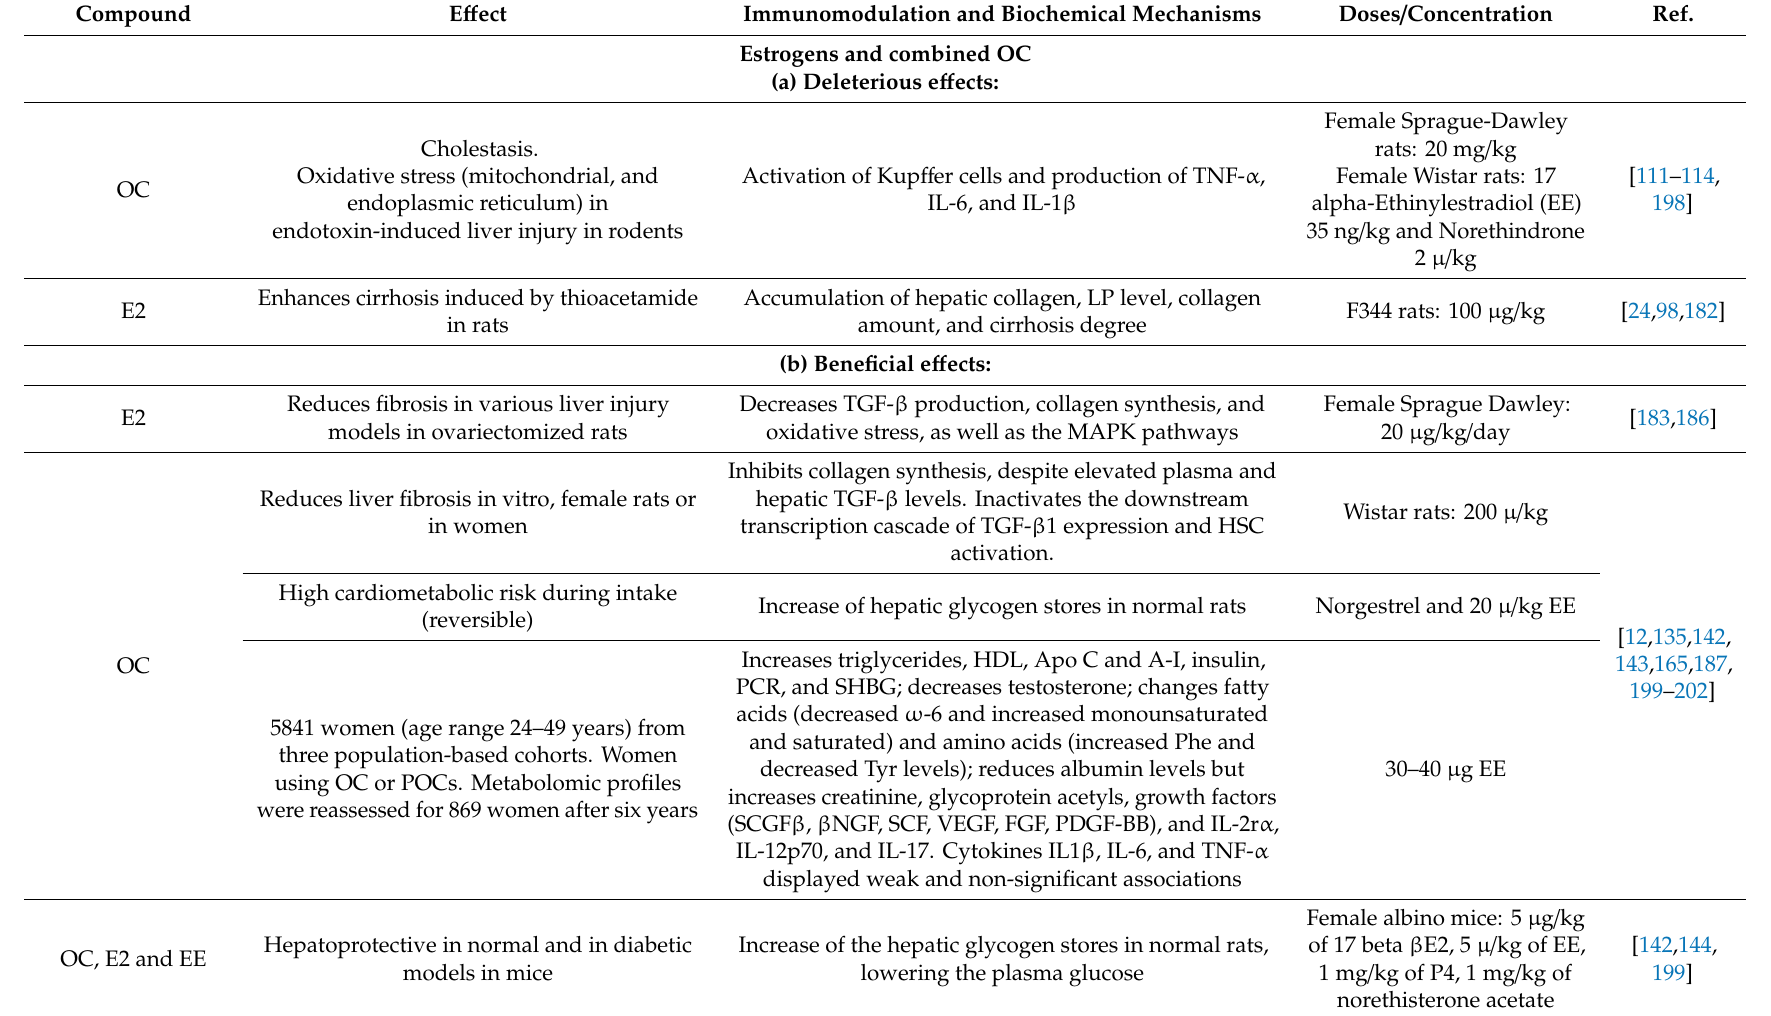
Table 1. E ff ects of female sex hormones, oral contraceptives, and phytoestrogens on the liver.